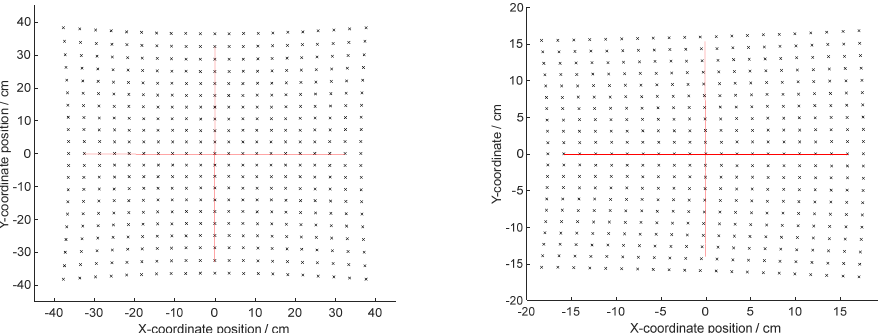
Figure 8. The point cloud distribution of the scanning plane at different MEMS vibration angles and different light incidence angles (left image: pillow distortion effect; right image: skew distortion effect).